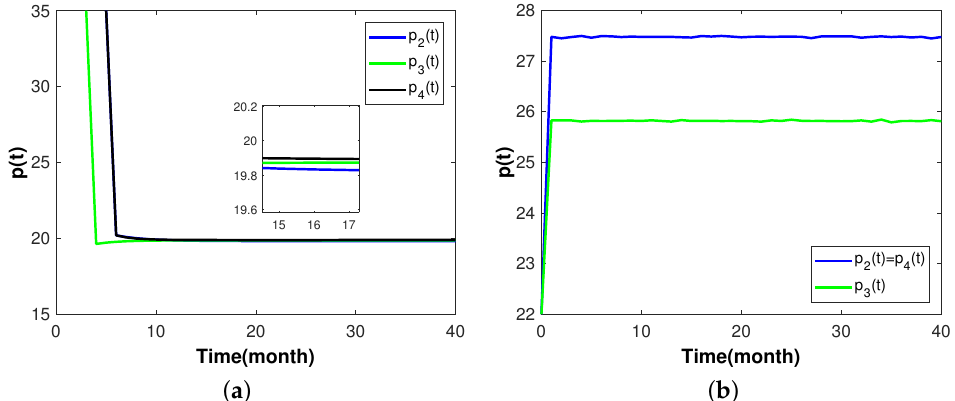
Figure 8. Optimal strategies’ results about prices. ( a ) Optimal strategies’ results of prices based on the first group of parameters. ( b ) Optimal strategies’ results of prices based on the second group of